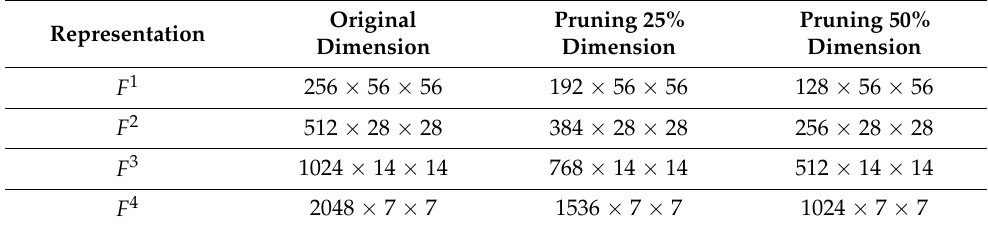
Table 1. Dimension comparison of each layer before and after